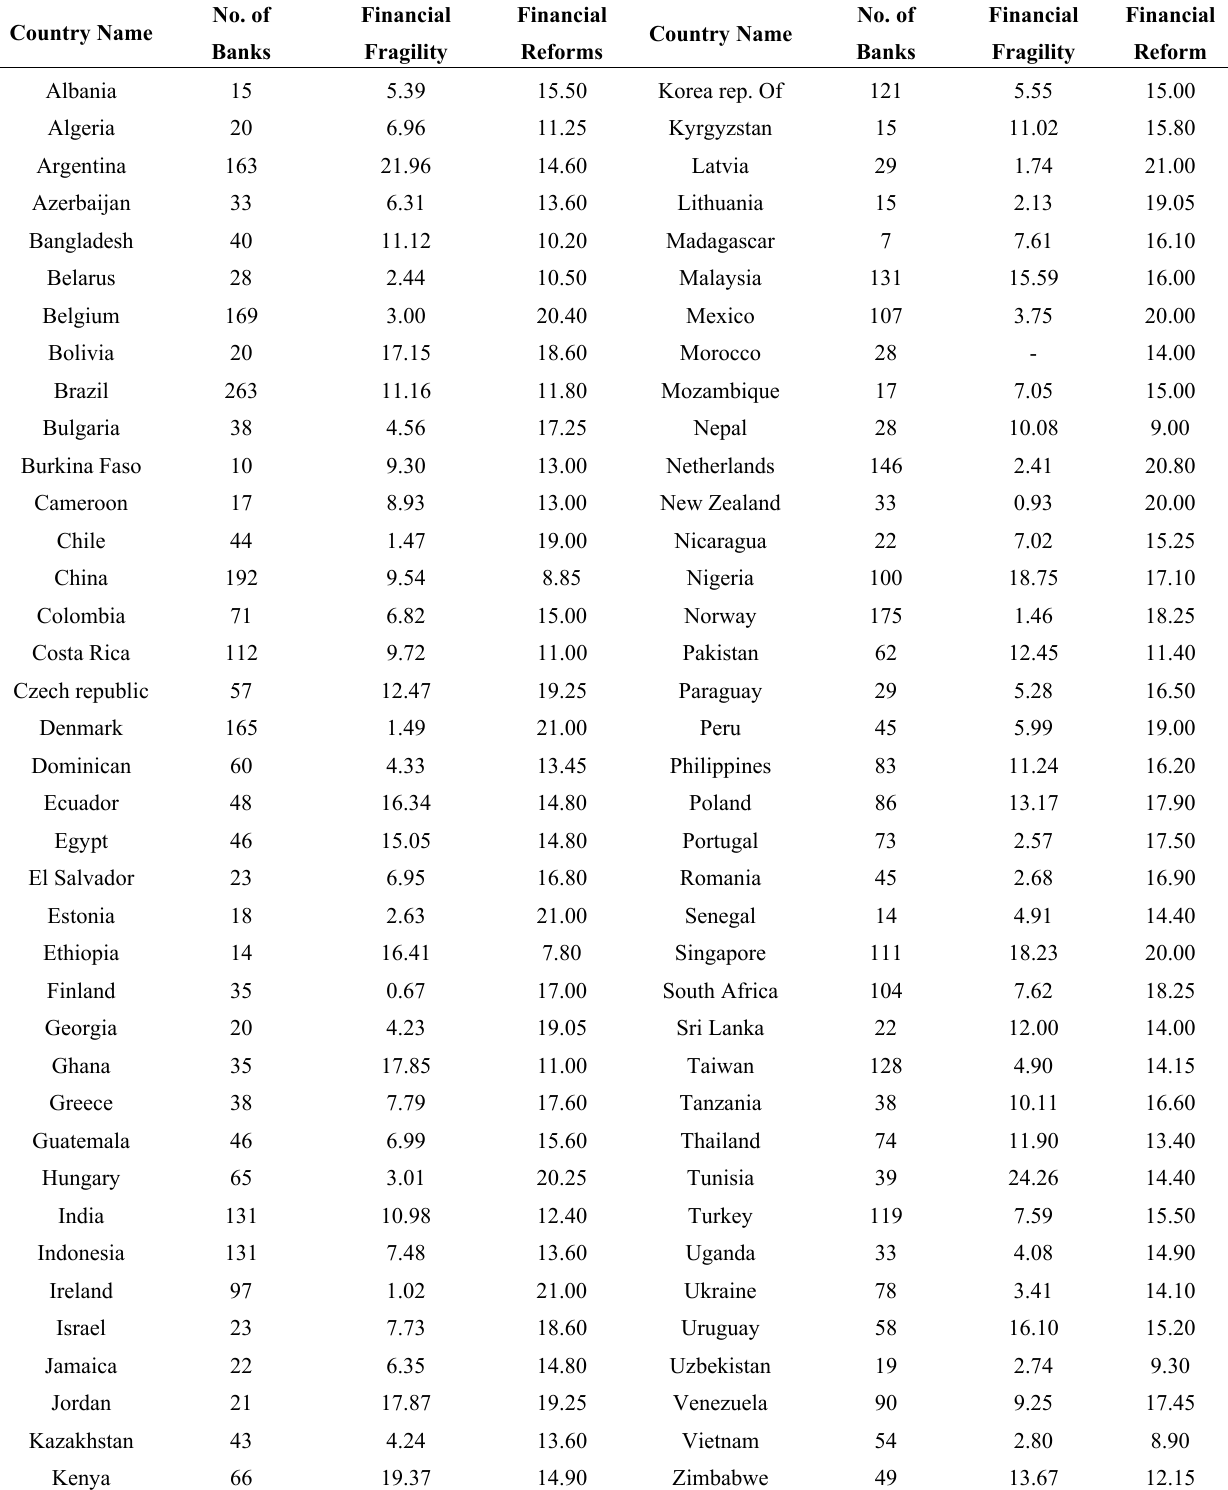
Table 1. List of countries by financial fragility, financial reforms and by No. of